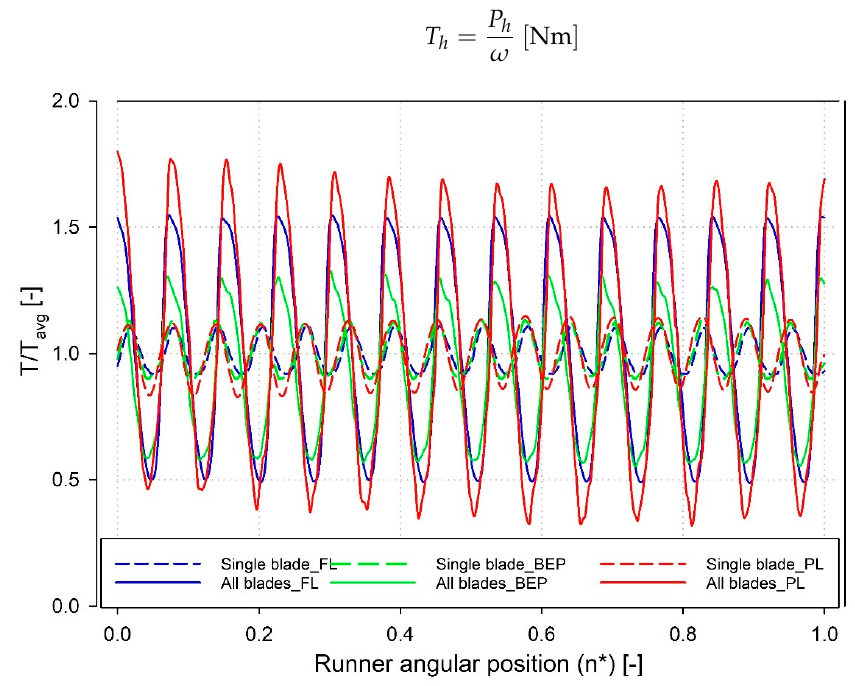
Figure 18. Torque oscillations for various operating conditions.